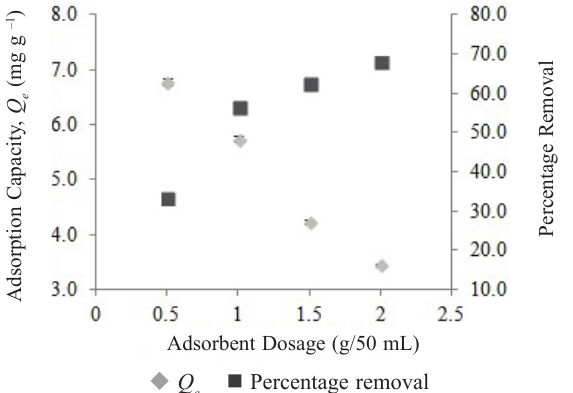
 Q Fig. 11 – Effect of pH on percentage removal and adsorp- tion capacity for Reactive Red 141 adsorption (initial dye con- centration = 200 mg L –1 ; adsorbent dosage = 1.0 g/50 mL; contact time = 220 min)